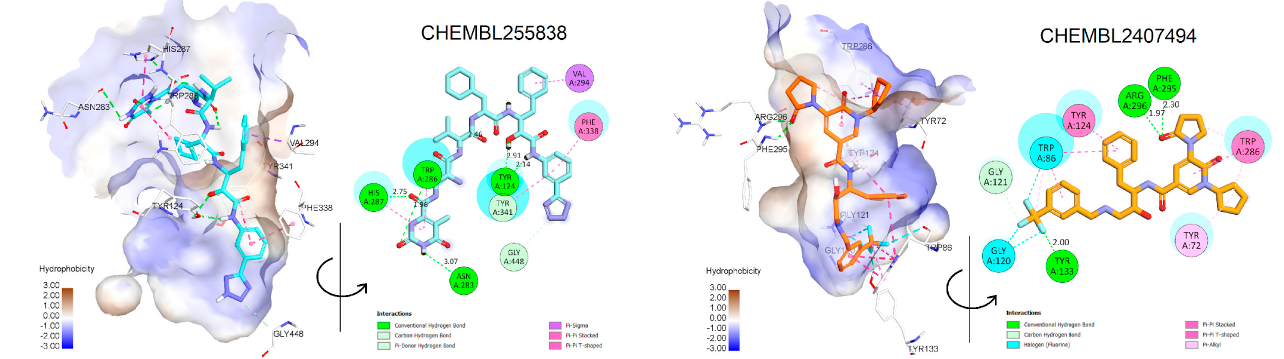
Figure 6. Two- and three-dimensional docking conformations of two exemplary dual inhibitors estimated by experimental and rule-based approaches in the active site of AChE.